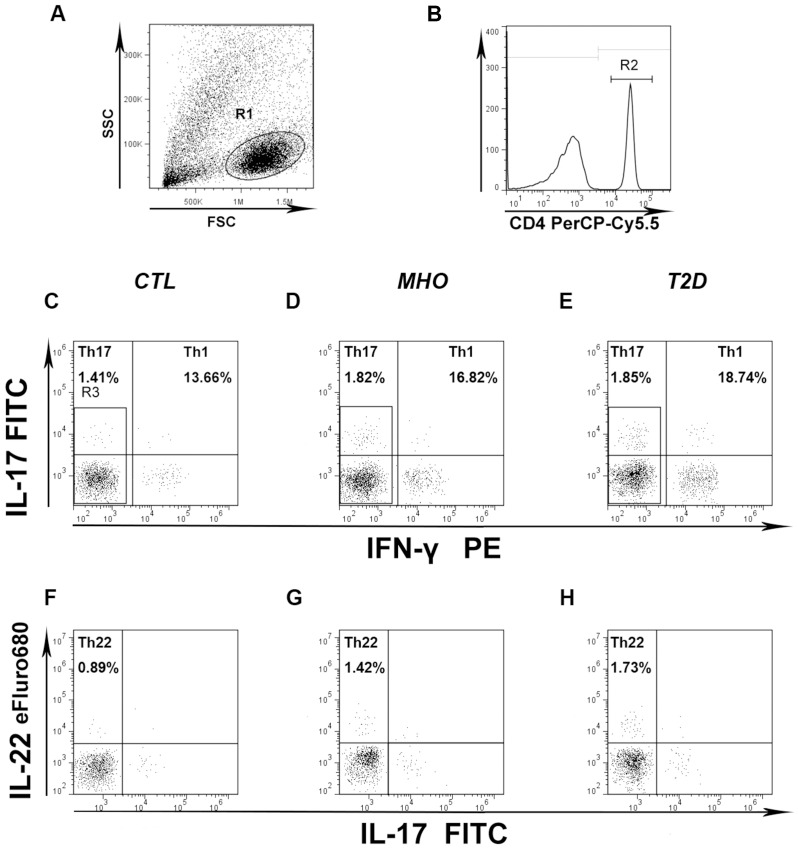
Gating strategy and representative dot plots for flow cytometry analysis.CD4+ T cells (B) were gated from lymphocytes (A) for further phenotyping. (C, D, E) Representative dot plots of peripheral Th1 (CD4+ IFNγ+; UR plus LR quadrant) and Th17 frequencies (CD4+ IFNγ−IL-17+; UL quadrant) from CTLs, MHO, and T2D patients. (F, G, H) Representative FCM dot plots of peripheral Th22 cells (CD4+ IFNγ−IL-17−IL-22+; UL quadrant) from CTLs, MHO, and T2D patients. Numbers in each plot denote the percentages of the indicated helper T subset in the total CD4+ T-cell population.